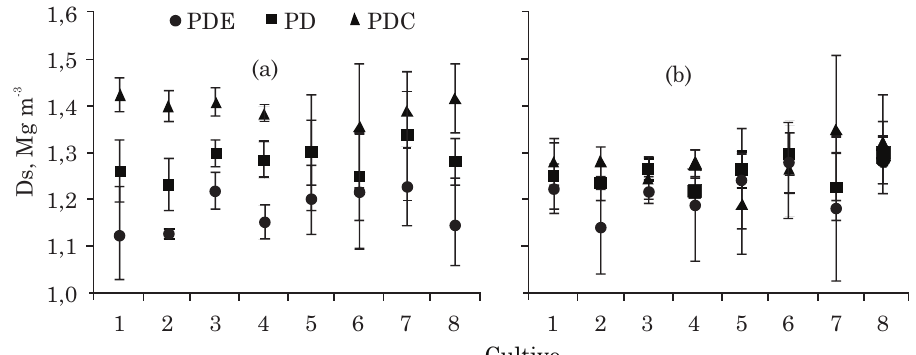
Figura 1. Efeito dos níveis de compactação na densidade do solo (Ds) das profundidades de 0,07 m (a) e 0,25 m (b). Para os cultivos de 1 a 4, a compactação e a escarificação foram aplicadas em setembro de 2010 e, para os cultivos de 5 a 8, apenas a compactação foi reaplicada em agosto de 2011. Barras verticais representam o desvio-padrão.